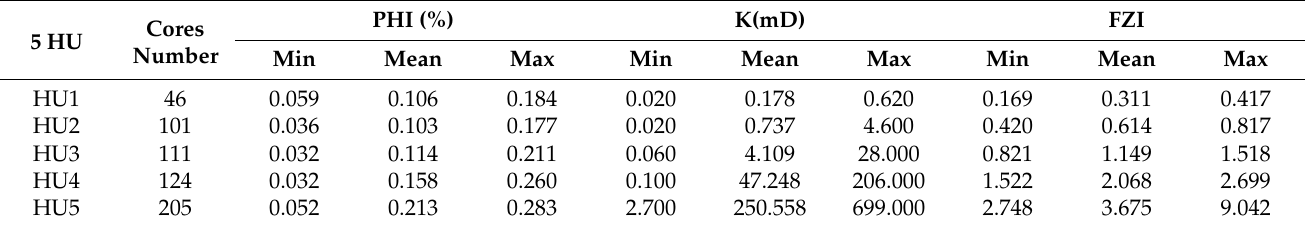
Table 2. The final simple statistics of PHI, K and FZI from the results of FCM method for 5 HU.